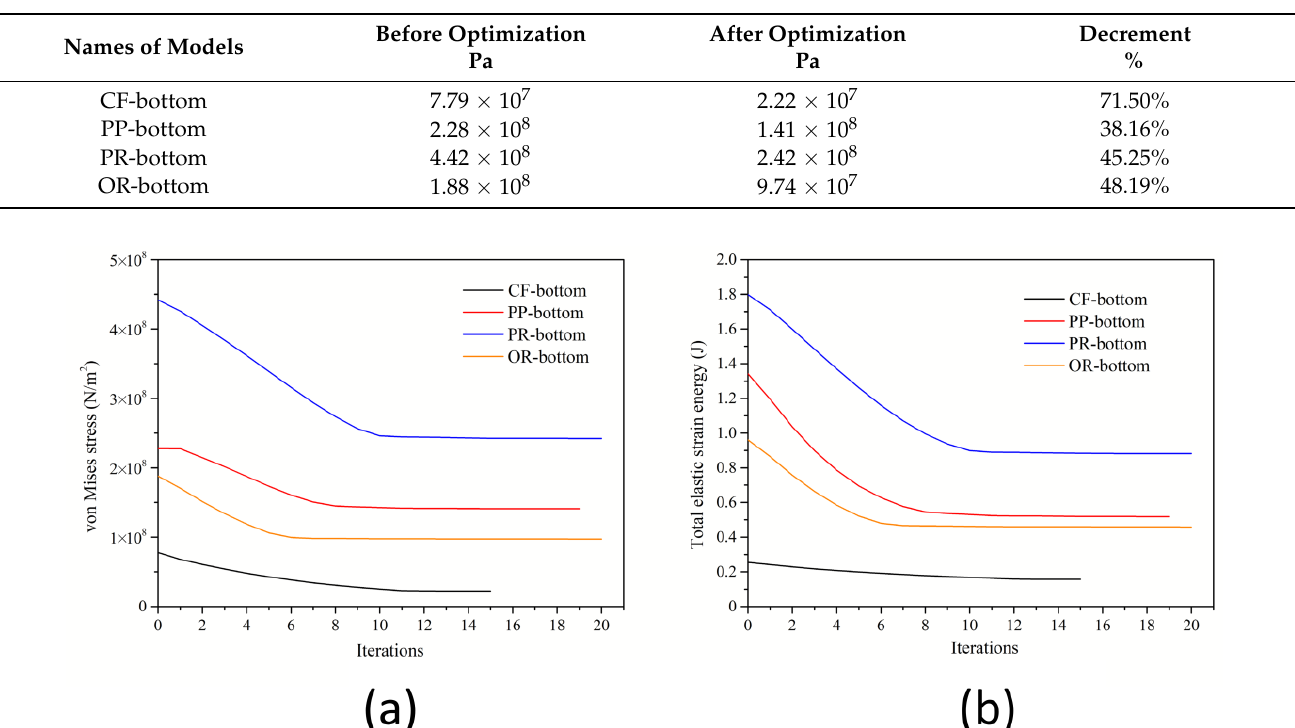
Figure 4. Diagrams of the overall maximum principal stress-iteration times ( a ) and the total elastic strain energy-iteration times ( b ).